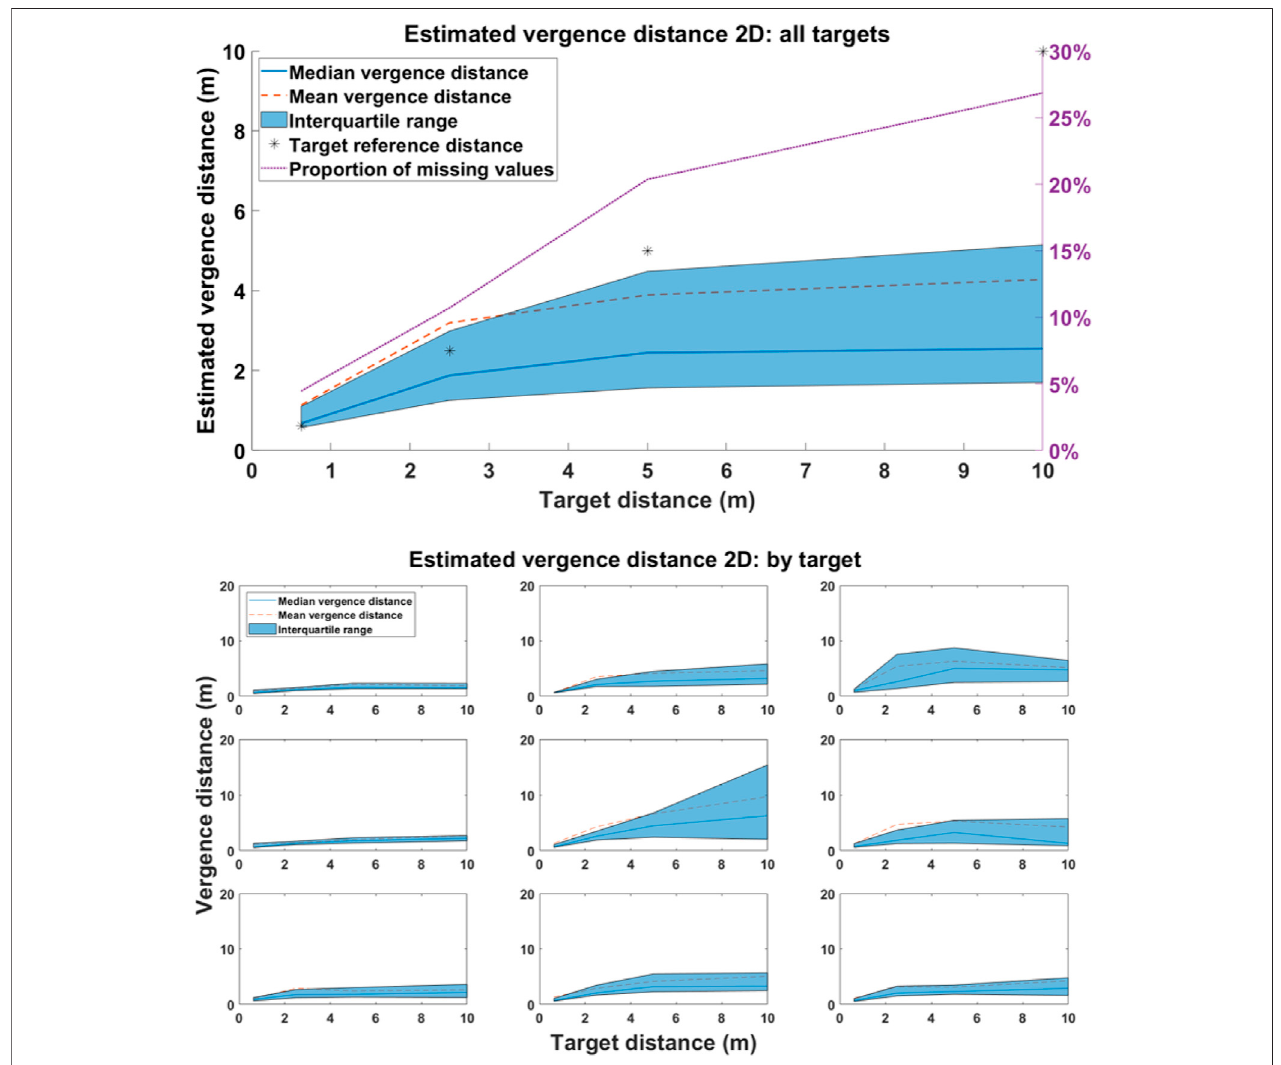
FIGURE 7 | Vergence depth estimates using the 2D distance estimation method ( Section 4.3 ). The upper plot illustrates distance estimates across all target positions at a given depth as well as the percentage of trials for which no valid solution was available. The lower plots illustrate the distance estimates per target at each